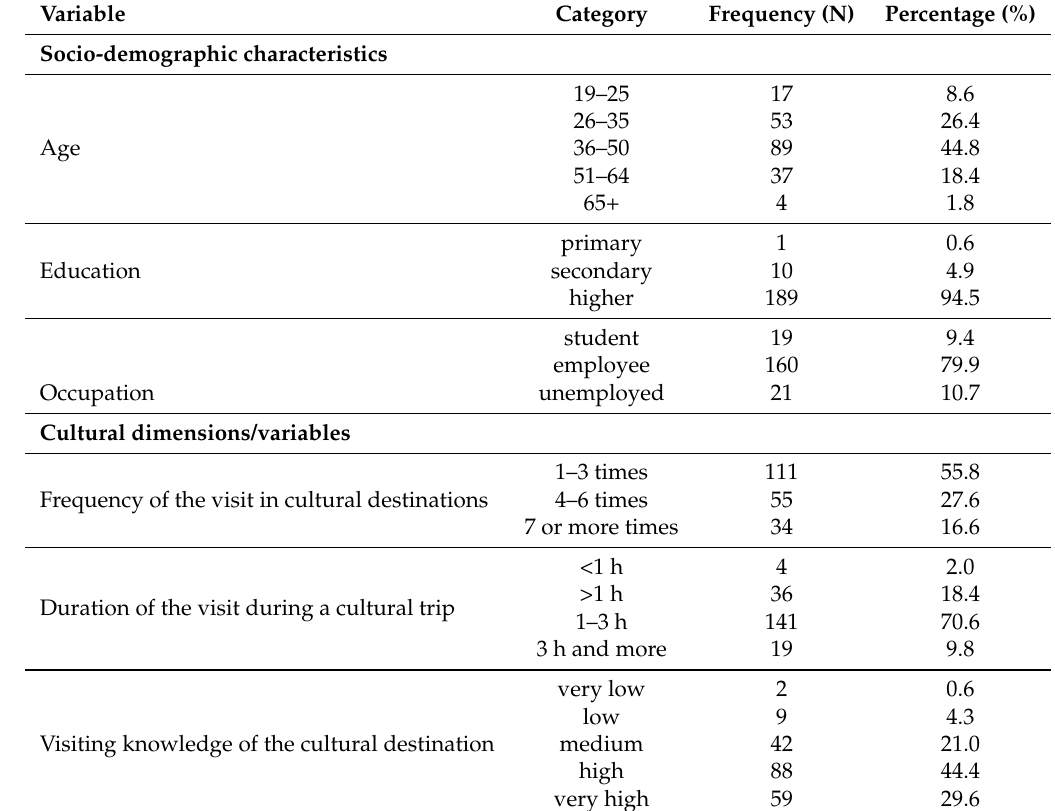
Table 1. Sample characteristics/Questionnaire